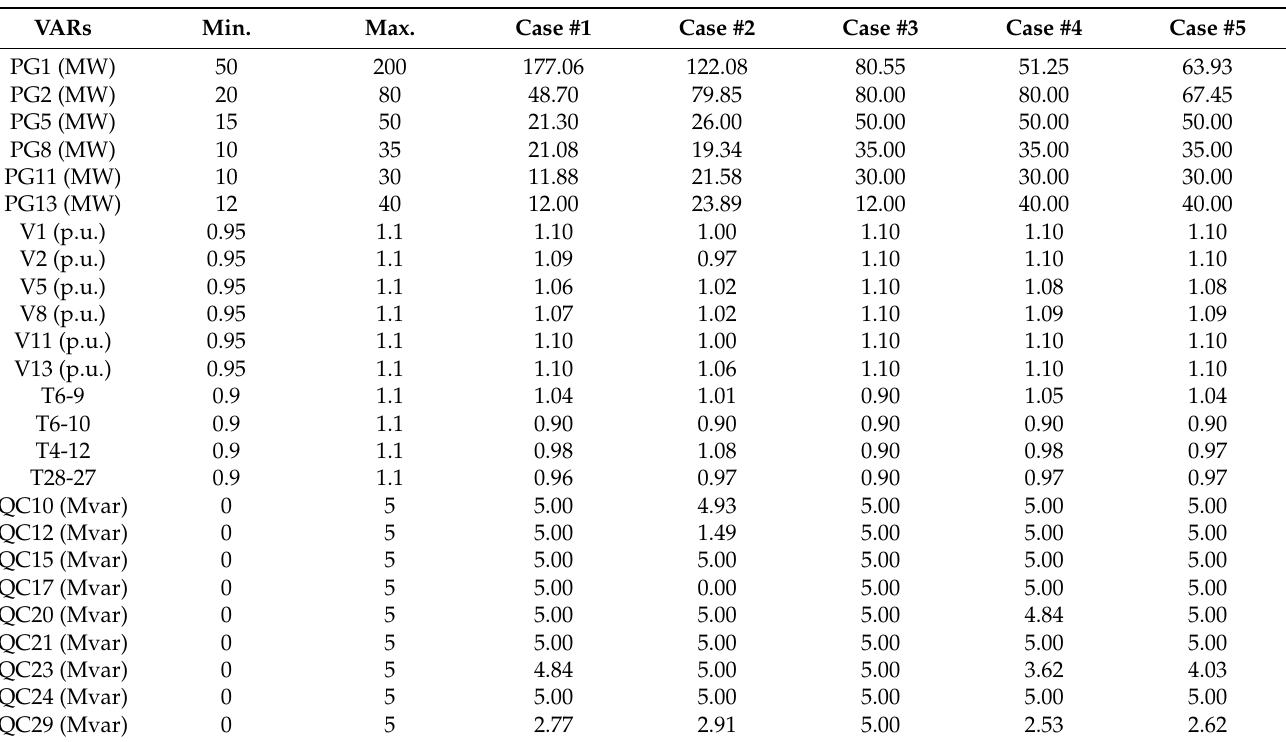
Table A1. Control variables of single objective functions for IEEE 30-bus test system using TFWO.